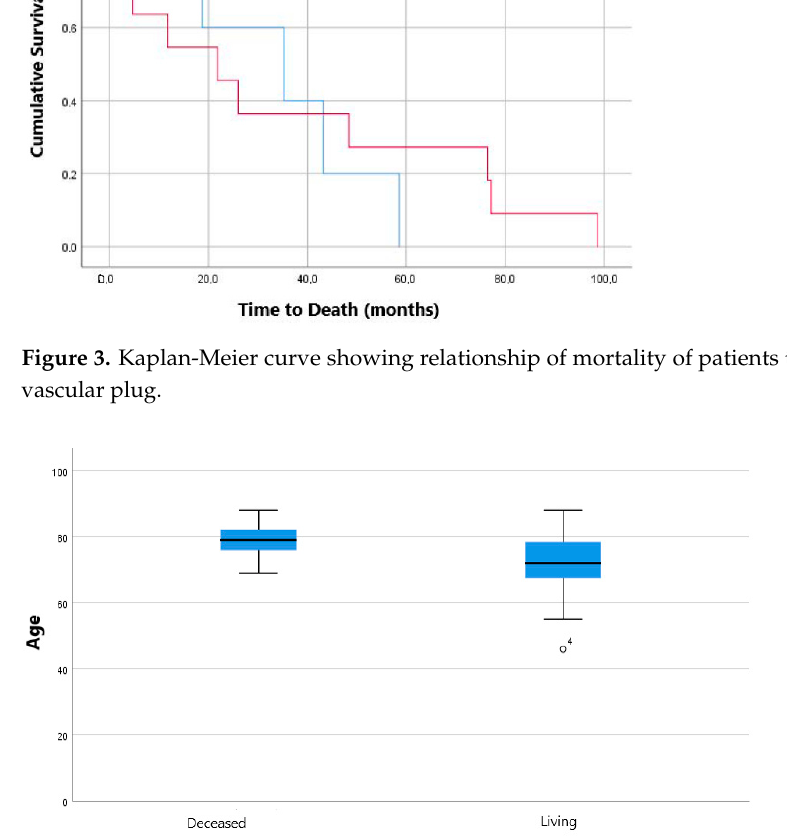
Figure 5. Boxplot showing relationship of endoleak occurrence at 1 month and aneurysmal sac var- iation at the same temporal endpoint. Outliers are marked with a “*” and the case number.